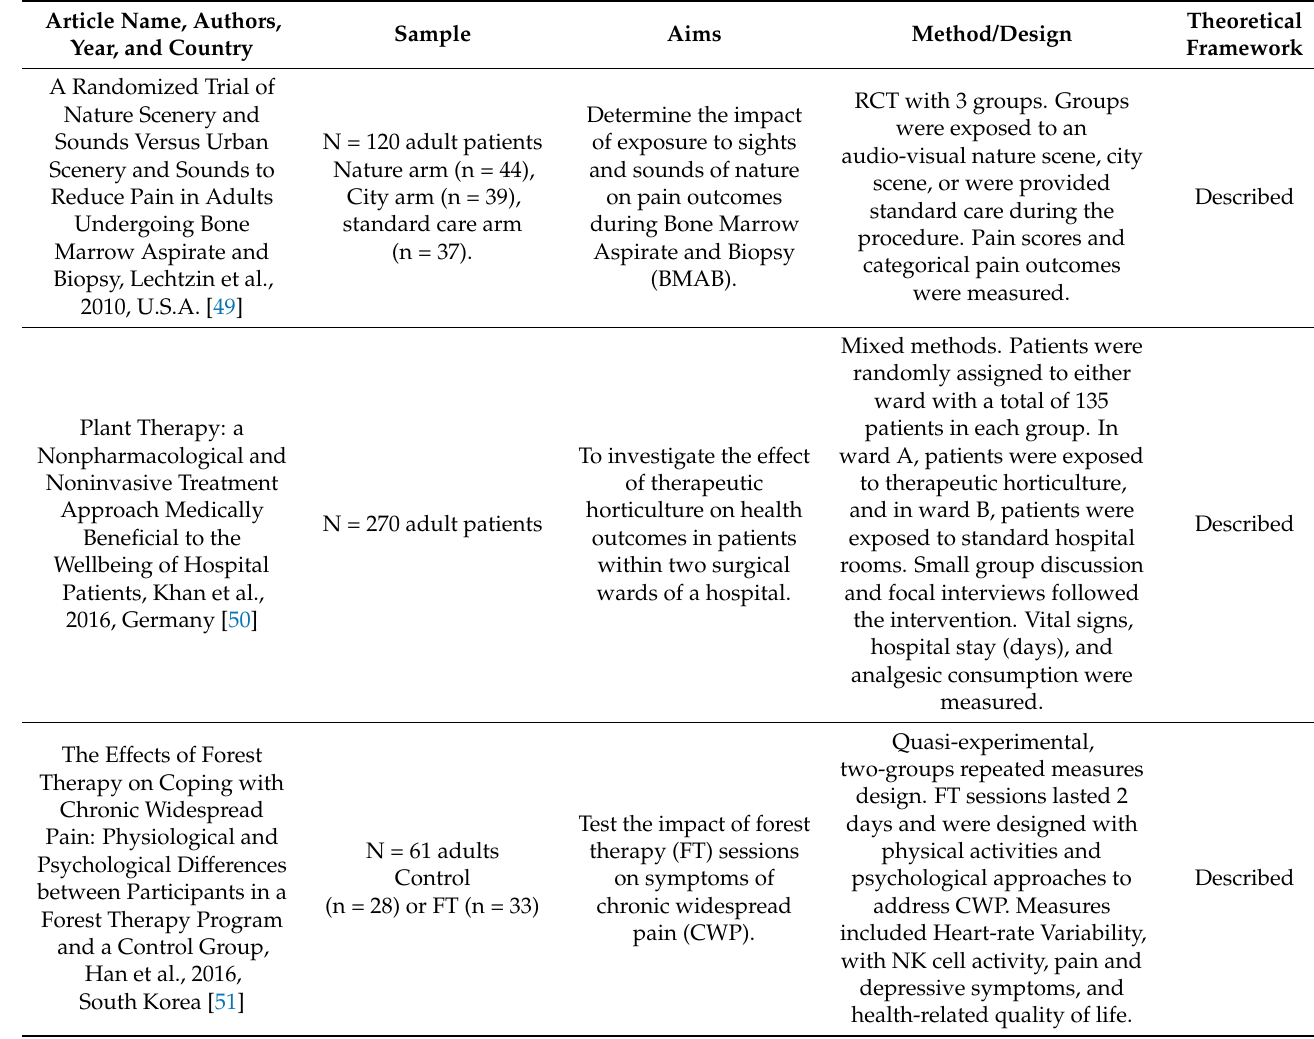
Table 1. Articles included in the theoretical analysis based on the literature